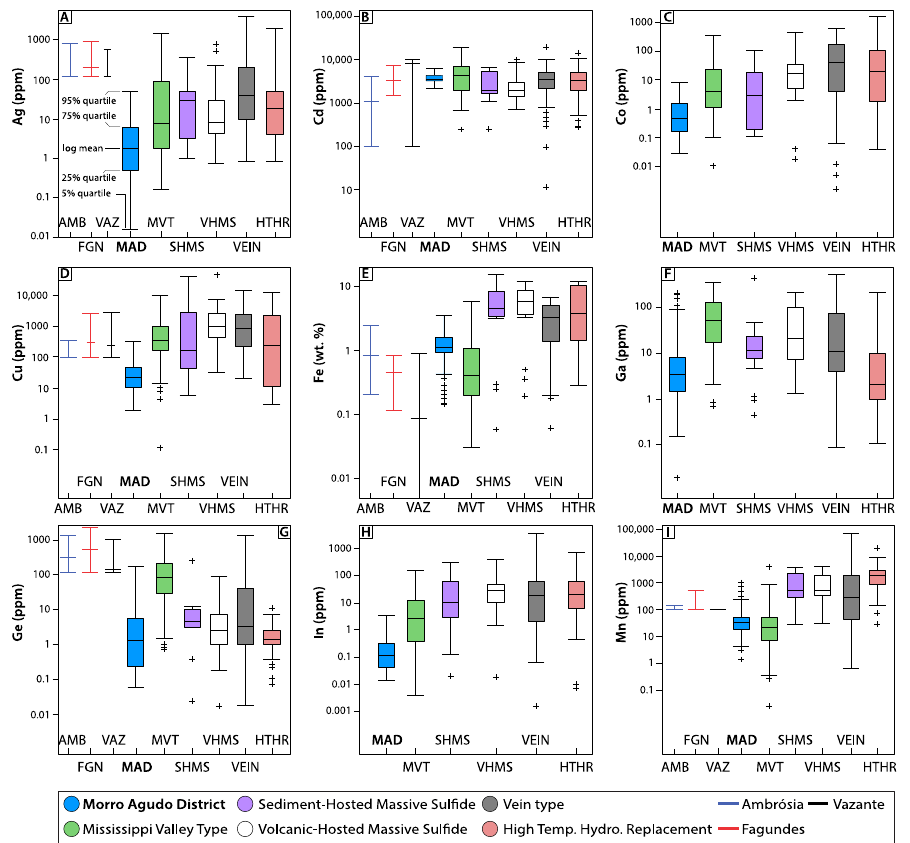
Figure 17. Box-and-whisker plots of minor and trace elements in sphalerite ( A ) silver; ( B ) cadmium; ( C ) cobalt; ( D ) copper; ( E ) iron; ( F ) gallium; ( G ) germanium; ( H ) indium; and ( I ) manganese within the Morro Agudo district compared with known compositional ranges of elements for Mississippi Valley-type (MVT), Sediment-Hosted Massive Sulfide (SHMS), Volcanic-Hosted Massive Sulfide (VHMS), Vein-type (VEIN), or High-Temperature Hydrothermal Replacement (HTHR) deposits (Frenzel et al. [27] and references therein) and other zinc deposits in the Vazante-Paracatu Mineral Belt [6]. Note the logarithmic scale and corresponding mean value. Table 7. Previously reported mean trace element compositions (Fe in wt. % and other elements in ppm) of sphalerite and galena from the Fagundes, Ambrósia, and Vazante deposits. Data from Mon- teiro et al. [6] and references therein.